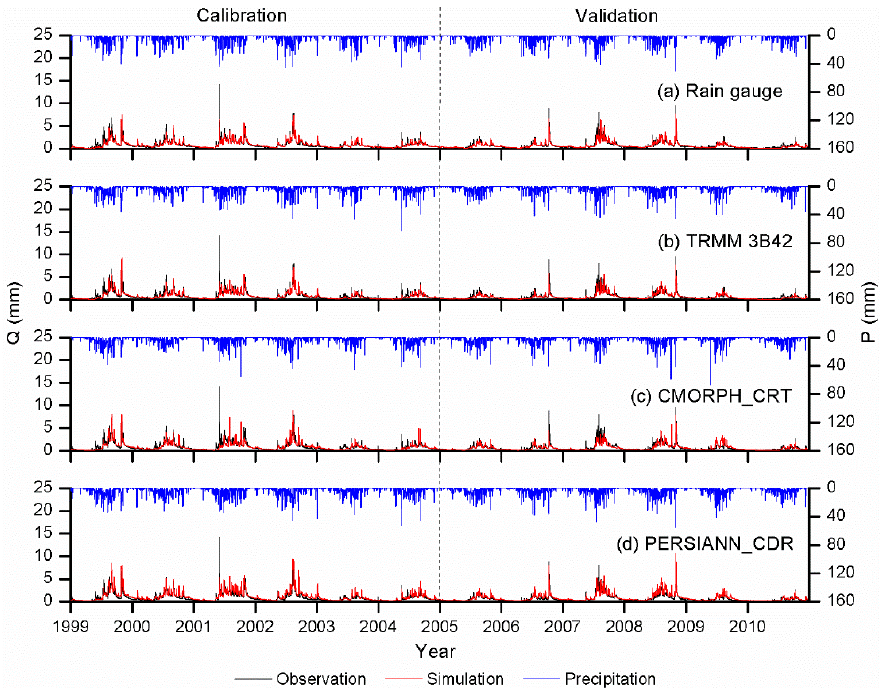
Figure 6. Simulated (red) and observed (black) daily streamflow under Scenario I from: ( a ) rain gauge data; ( b ) TRMM 3B42; ( c ) CMORPH_CRT; and ( d ) PERSIANN_CDR. Blue lines show precipitation data.